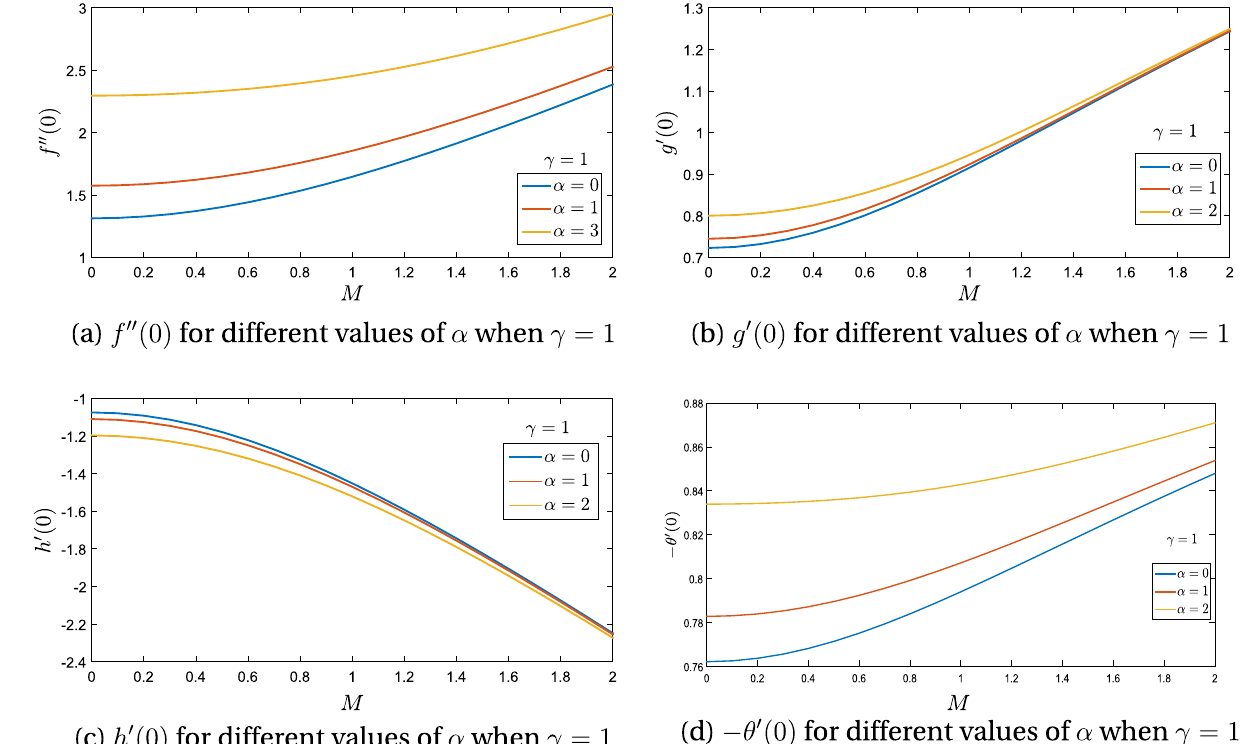
Figure 7. Skin friction and heat flux against magnetic parameter M and rotation ratio parameter α